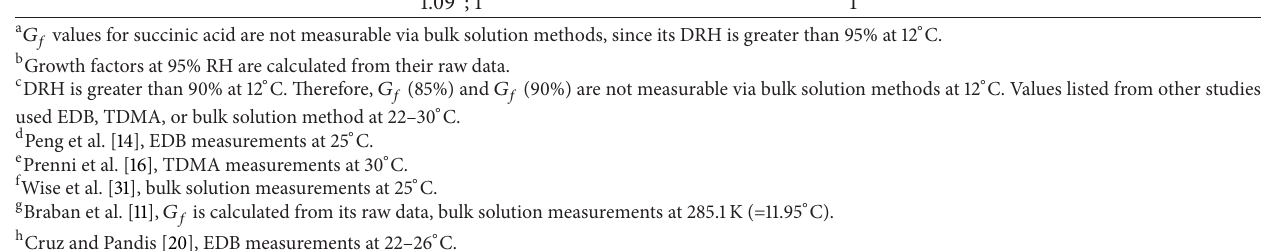
Figure 2: Water activity of (a) malonic acid and (b) glutaric acid. Each data point represents the average of 4 replicate measurements; error bars on measured data represent standard deviation of 0.4% (discussed in Section 2). The measurement data by Peng et al. (2001) [14] and Braban et al. (2003) [11] were at 25 ∘ C and 285.1 K (=11.95 ∘ C), respectively. Table 2: Growth factors ( 𝐺 𝑓 ) for malonic and glutaric acids in this study (at 12 ∘ C) versus other studies a . 𝐺 𝐺 𝐺 𝑓 (85%) 𝑓 (90%) 𝑓 (95%) This study Other studies This study Other studies This study Other studies b 1.40 d ; 1.37 e Malonic acid 1.43 1.15 e ; 1.10 Glutaric acid